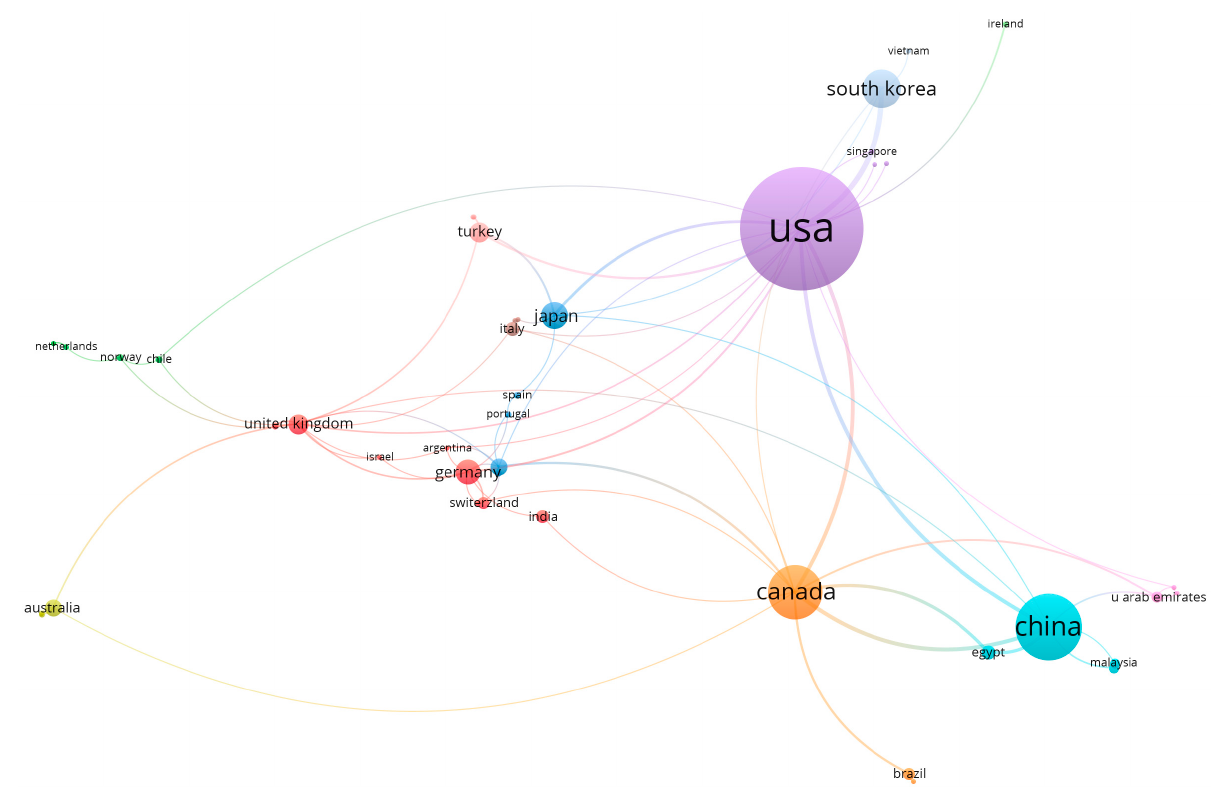
Figure 6. Co-authorship network of countries in the research on CBD_NDT.